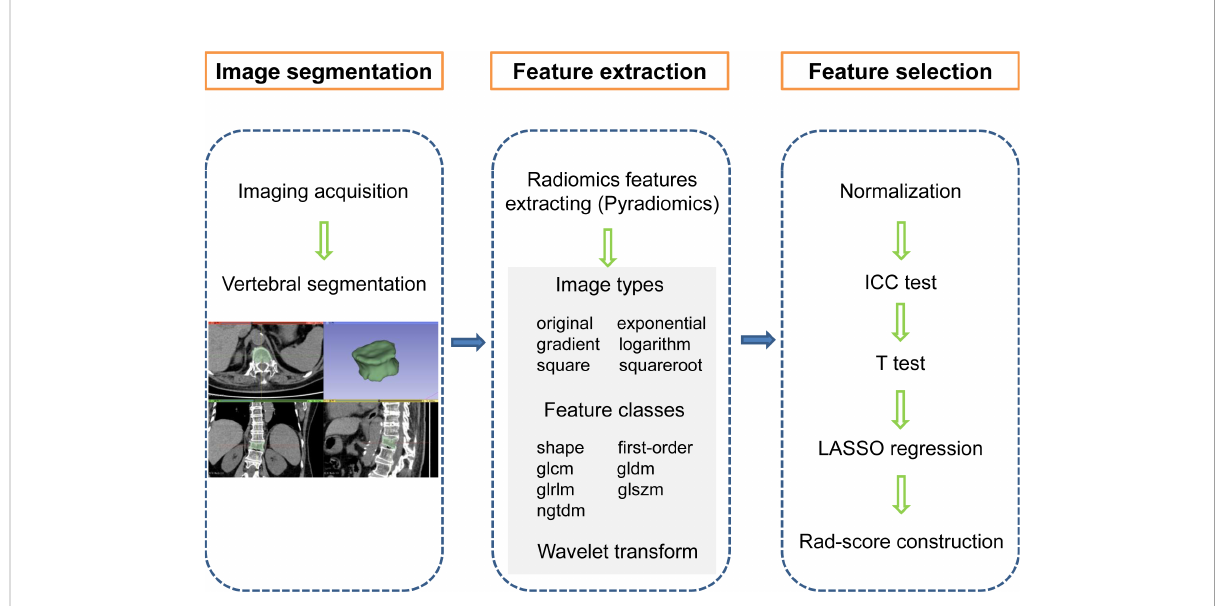
FIGURE 2 Radiomics work fl ow showing the construction of a CT imaging-based rad-score for an OVCF patient. The steps include (1) image segmentation, (2) feature extraction, and (3) feature selection. fi rst-order, fi rst order statistics; glcm, gray-level co-occurrence matrix, gldm, gray-level dependence matrix; glrlm, gray-level run length matrix; glszm, gray-level size zone matrix; ngtdm, neighbouring grey tone difference matrix, ICC, intraclass correlation coef fi cient; LASSO, least absolute shrinkage and selection operator, Rad-score, radiomics